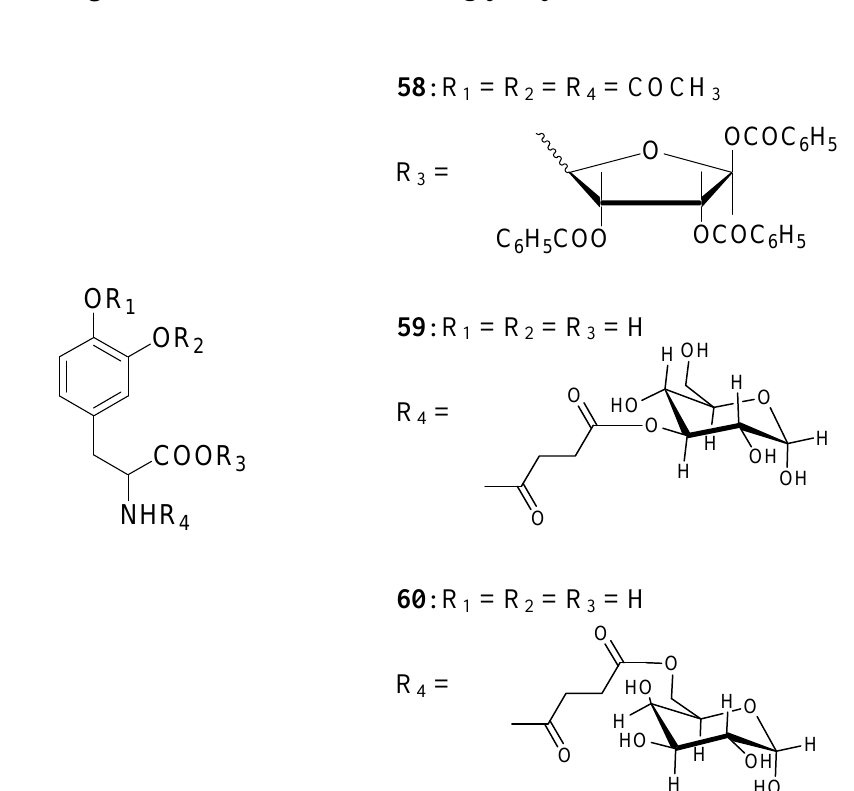
Figure 8 . Chemical structures of glycosyl-derivatives of